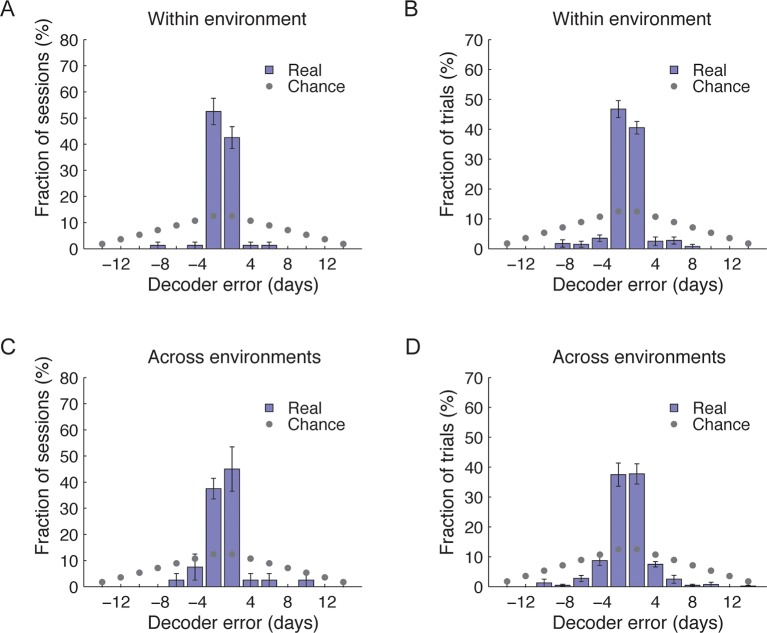
Time decoders accurately infer the time of the episode even when the tested session is excluded from the training data (A–D).(A,B) Distributions of the decoders’ errors in inferring the day from which the test sessions (A) or trials (B) were taken within environment. The decoder inferred either the recording day before or after the day the test data was taken from in 95% of the sessions and 87.25% of the trials, significantly higher than chance levels (gray dots). (C,D) Distributions of the decoders’ errors in inferring the day from which the test sessions (C) or trials (D) were taken across-environments. The decoder inferred either the recording day before or after the day the test data was taken from in 82.5% of the sessions and 75.25% of the trials, significantly higher than chance levels (gray dots). (z-test, p < 6 · 10−7 for all comparisons). Data are mean ± s.e.m.